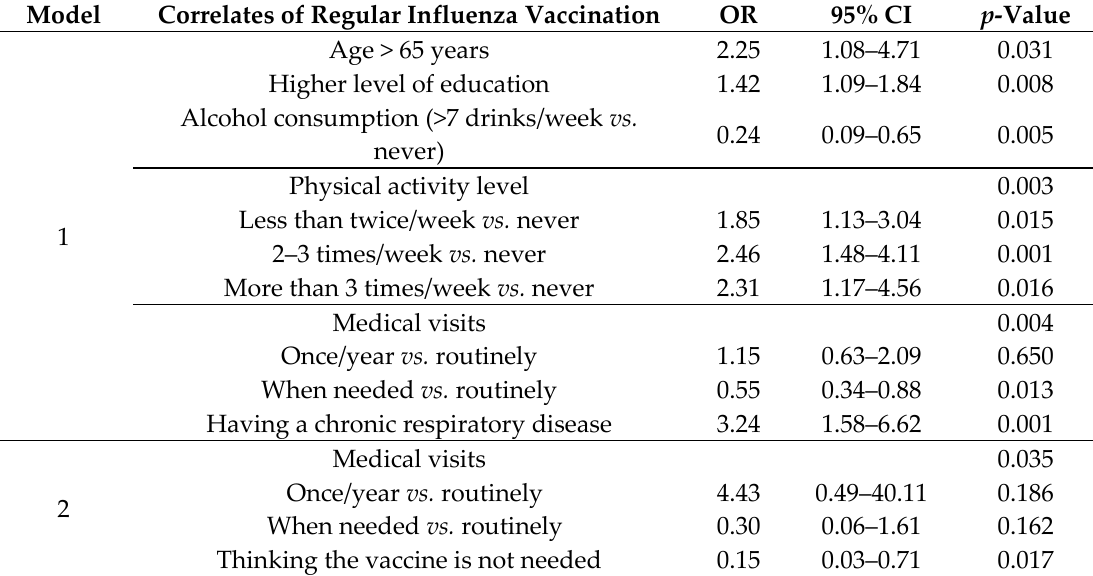
Table 5. Multivariate analysis: correlates of regular influenza